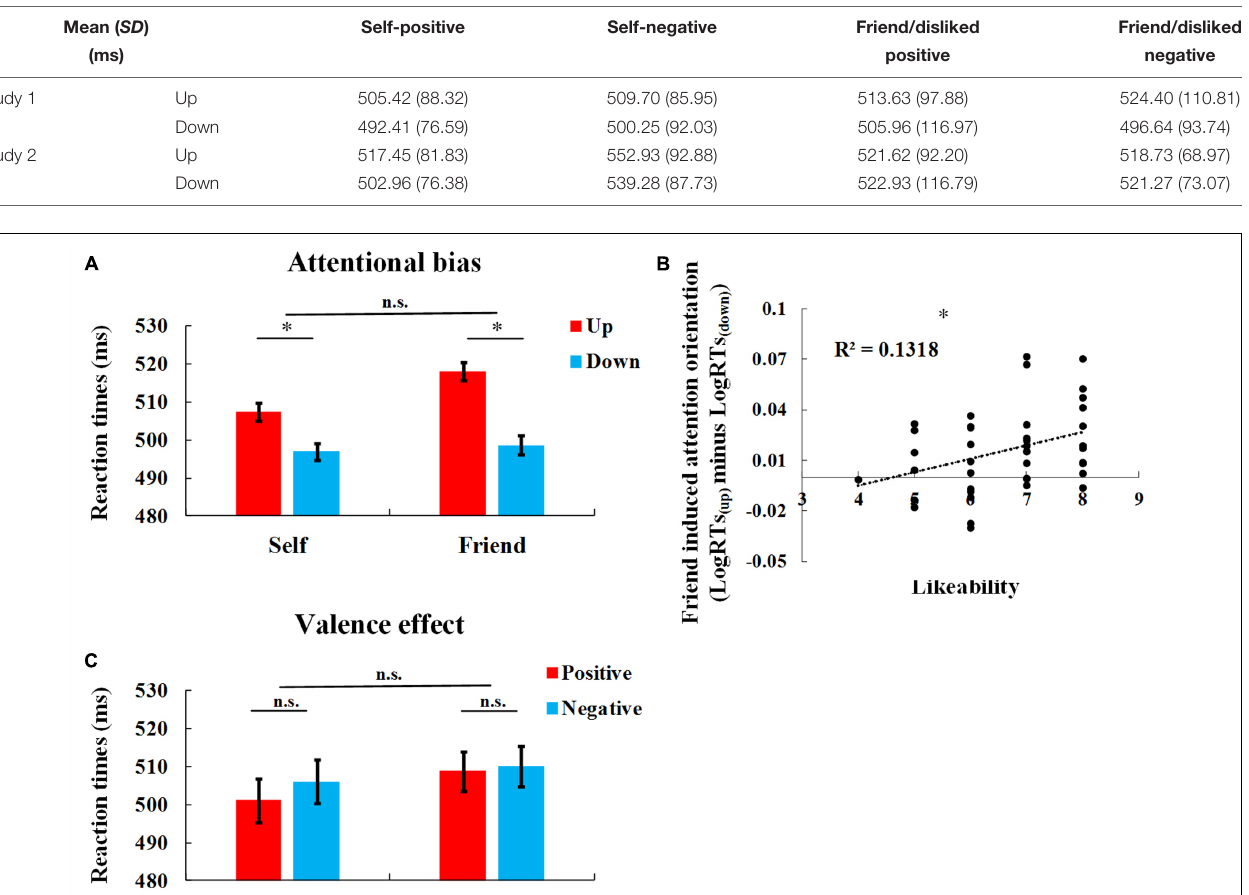
TABLE 1 | Mean RTs and SDs in the attention orientation task.